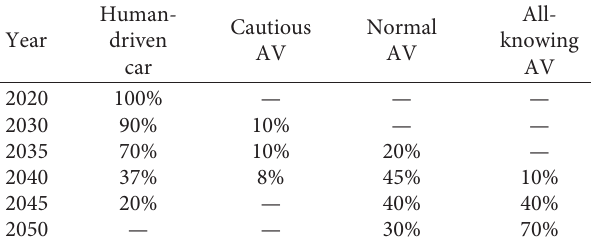
Table 4: Vehicle composition for each scenario of this study. Human- Cautious Normal Year driven AV AV car